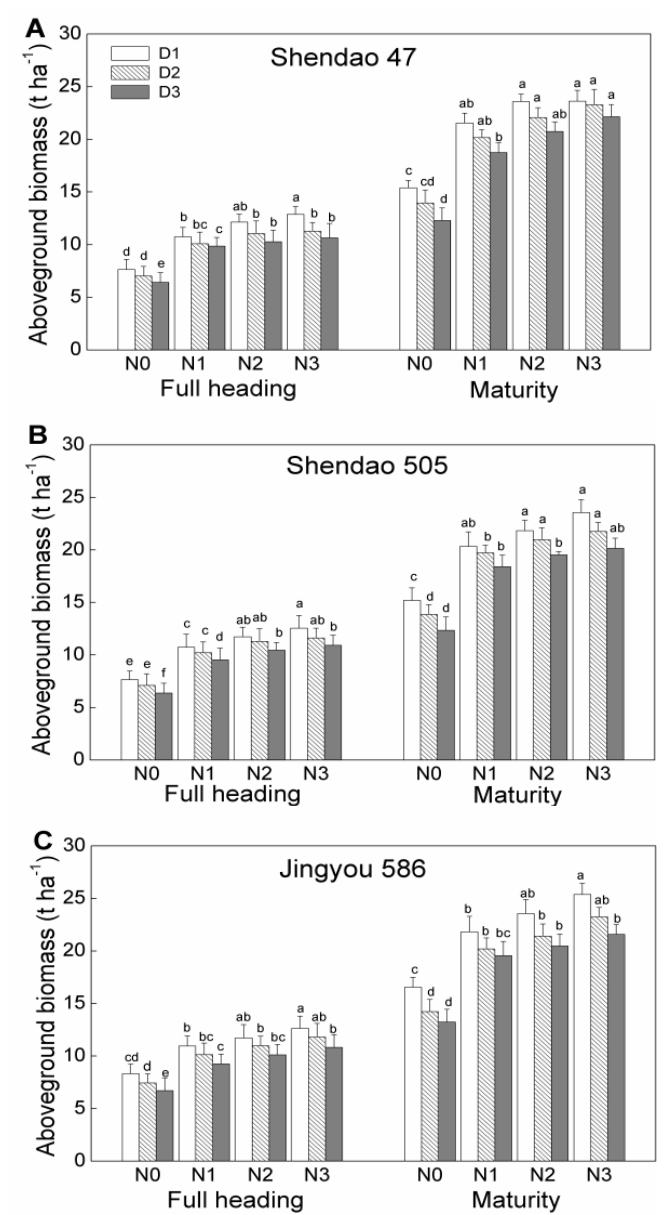
Figure 1. Mean aboveground biomass of rice cultivars Shendao 47 ( A ), Sendao 505 ( B ), and Jingyou 586 ( C ) at heading and harvest stages, averaged across locations and years. Error bars represent + S.E. of the mean. The S.E. was calculated across two sites and two years. Di ff erent letters indicate significant di ff erences at p < 0.05. N0, N1, N2, and N3 refer to nitrogen rates of 0, 140, 180, and 220 kg ha − 1 , respectively; D1, D2, and D3 refers to 25 × 10 4 , 16.7 × 10 4 , and 12.5 × 10 4 hills ha − 1 , respectively. The same definitions are used in Figure 2 below.